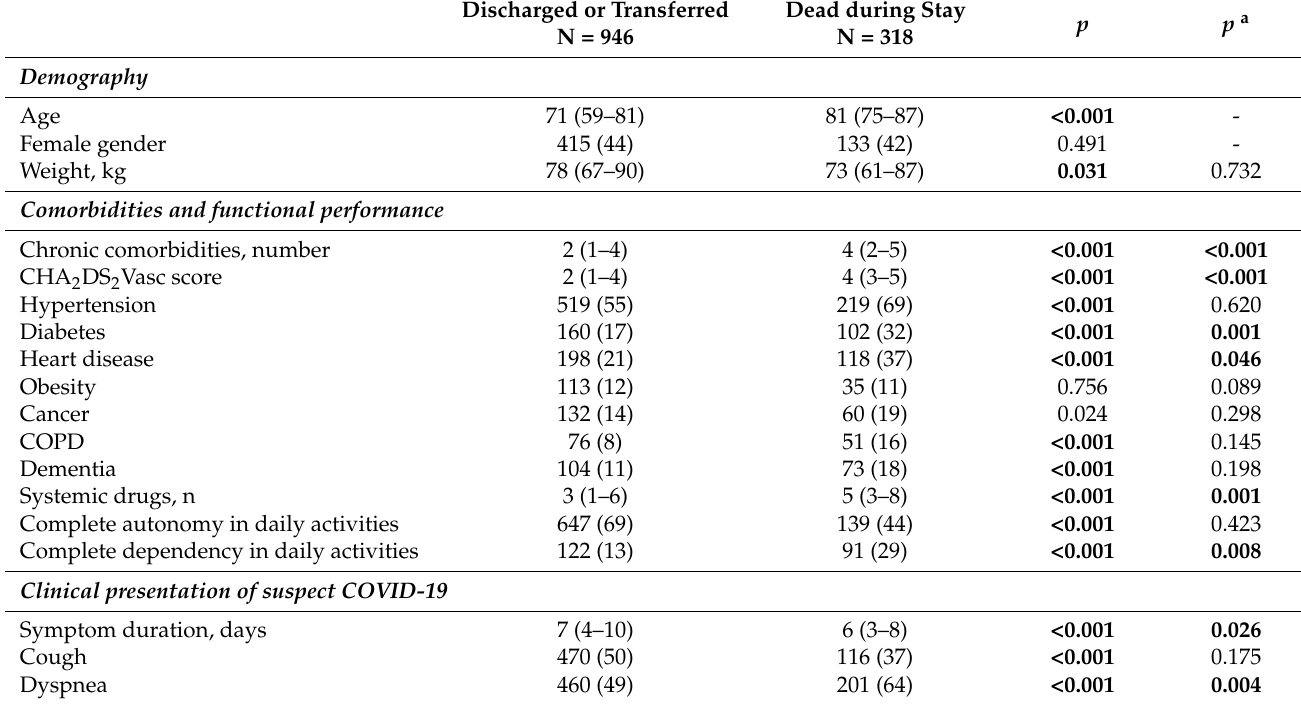
Table 5. Comparison of the demographic, anamnestic, and clinical features of patients hospitalized for suspect COVID-19, categorized according to the outcome (discharged/transferred vs. dead during